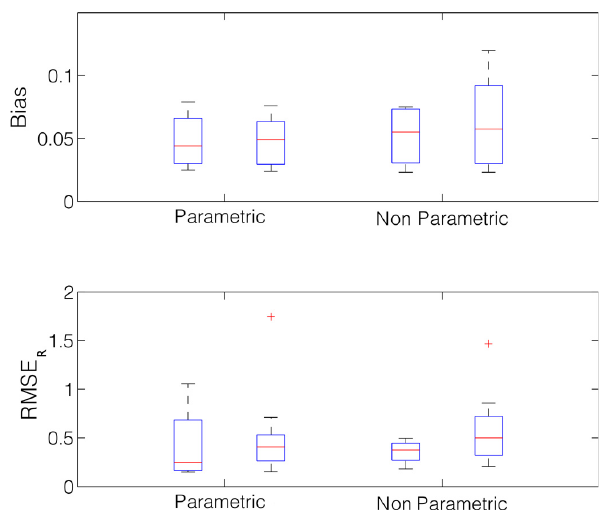
Fig. 9. Box-plot of both fitting techniques (parametric and non- parametric) for the log ratio bias and the RMSE R . The left box- plot for a given fitting methodology represents the results for the Z/R obtained for the same study case whereas the right box plot is the results obtained for the Z/R computed by the three other case